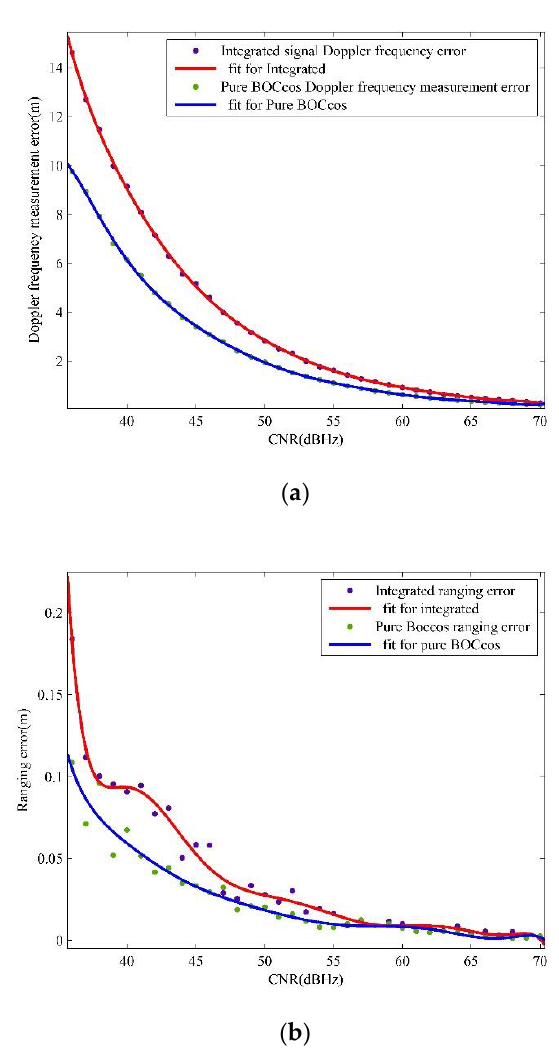
Figure 7. The ranging and doppler measurement performance of an integrated signal and pure signal: ( a ) Doppler frequency measurement results of integrated signal and pure BOCcos signal; ( b ) Ranging results of integrated signal and pure BOCcos signal.